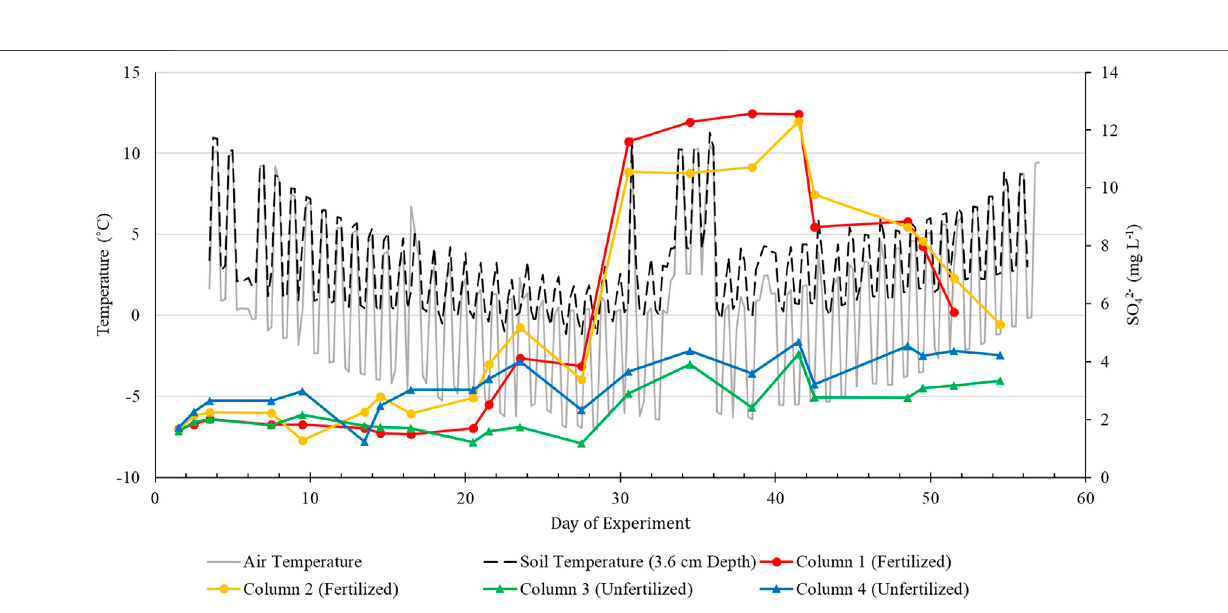
Frontiers in Environmental Science |